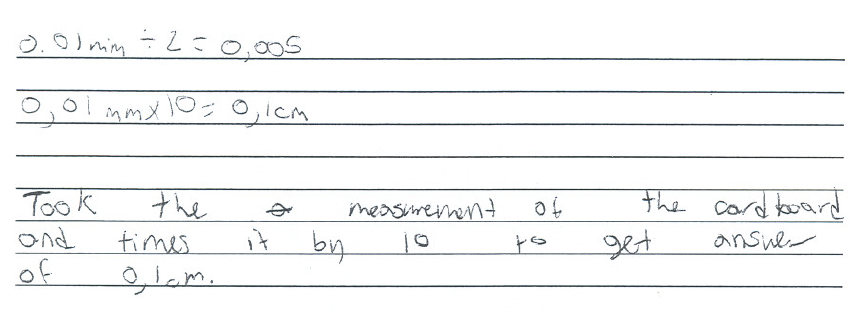
Figure 2: Individual learner 2’s calculation of problem